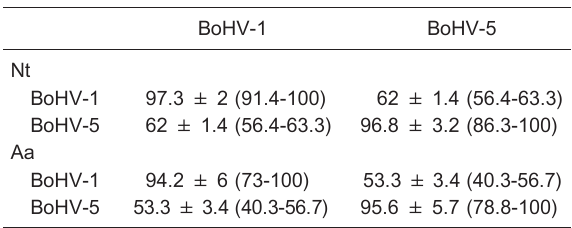
Table 2. Similarity levels among the nucleotide (nt) and amino acid (aa) sequences of the amino-terminal region of glycoprotein C of isolates/strains of bovine herpesvirus 1 (BoHV-1, n=22) and BoHV-5 (n=25).